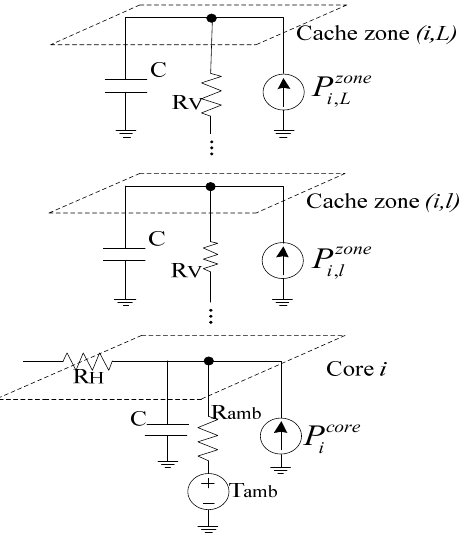
Figure 2. Thermal model of a super-core i .